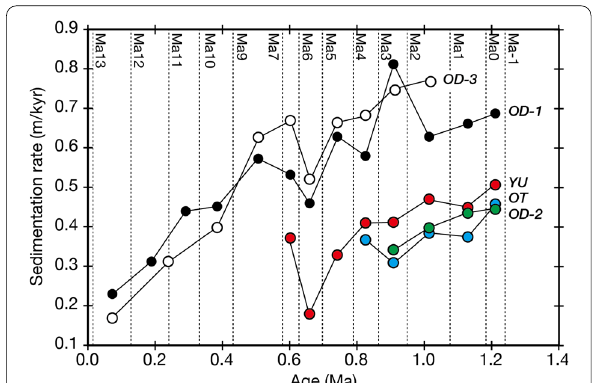
Fig. 4 Temporal variation of sedimentation rate at different core sites (Uchiyama et al.